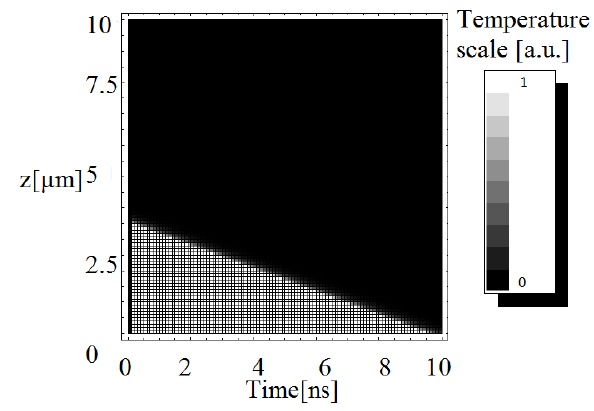
Figure 2. Electron temperature density evolution in time and space in the case of one laser pulse of 100 fs irradiation of an Au surface for 𝜏 = 1 𝑝𝑠 relaxation time.